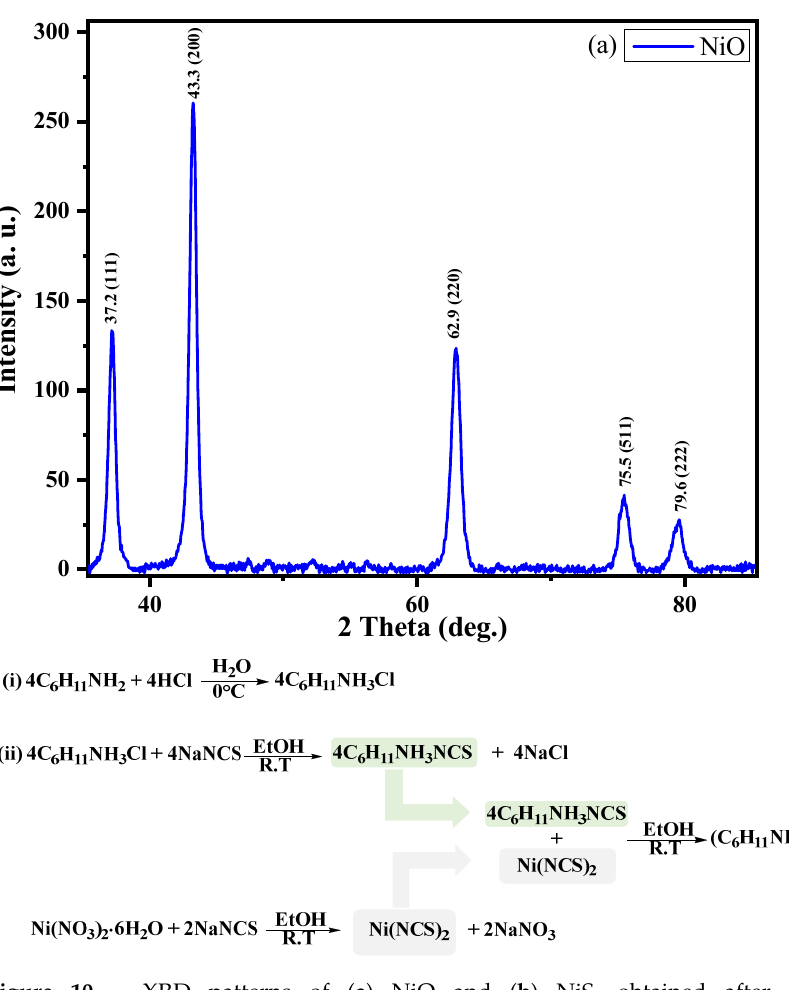
(4) The tabulated values (Table 6) are in agreement with previous data. Table 6. Crystallite size and lattice parameters of NiO and NiS. Sample